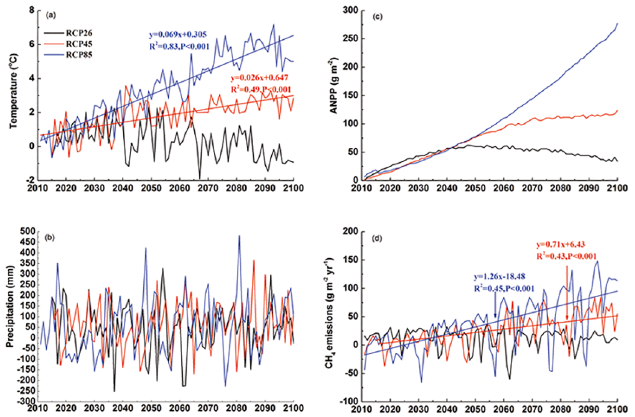
Fig 5. Projected area-weighted annual mean air temperature (a) and annual precipitation (b) by FGOALS, annual aboveground net primary productivity (c) by AVIM2 and CH 4 fluxes (d) by CH4MOD wetland from the wetlands of the Sanjiang Plain for RCP 2.6 (black line), RCP 4.5 (red line) and RCP 8.5 (blue line) relative to the average 2000s,